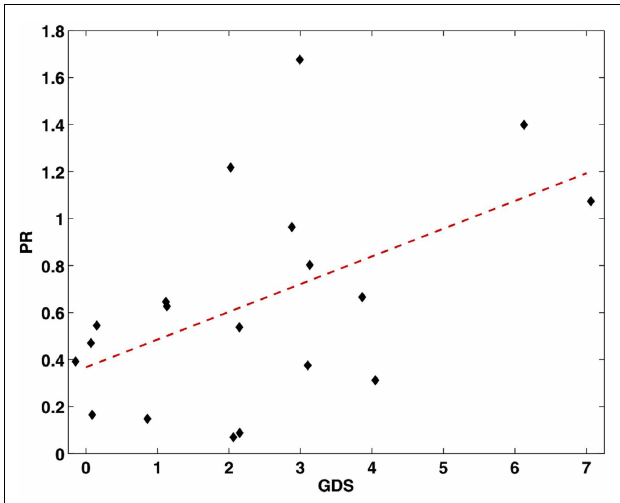
FIGURE 1 | Scatter plot showing the significant correlation between increased depressive scores from the GDS and faster progression rate (calculated by the PR equation, n =